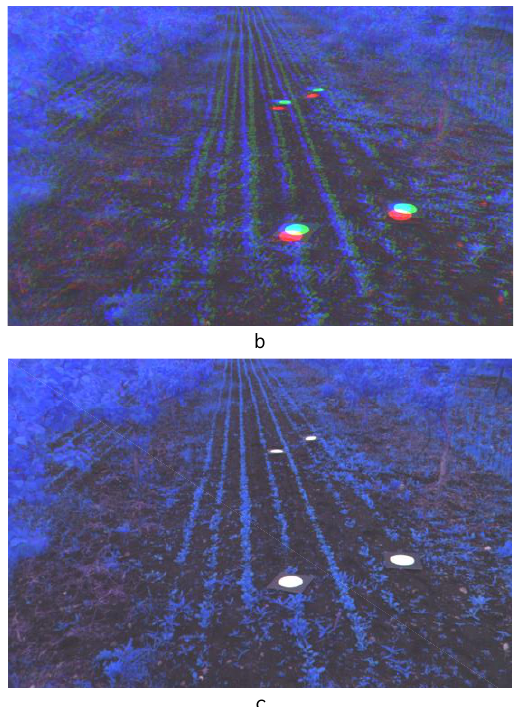
Figure 7. Example of band-to-band multispectral image registration; a) raw RGB image; b) false-color image generated by overlaying R, G, NIR bands before co-registration; c) false- color image generated by co-registered R, G, NIR